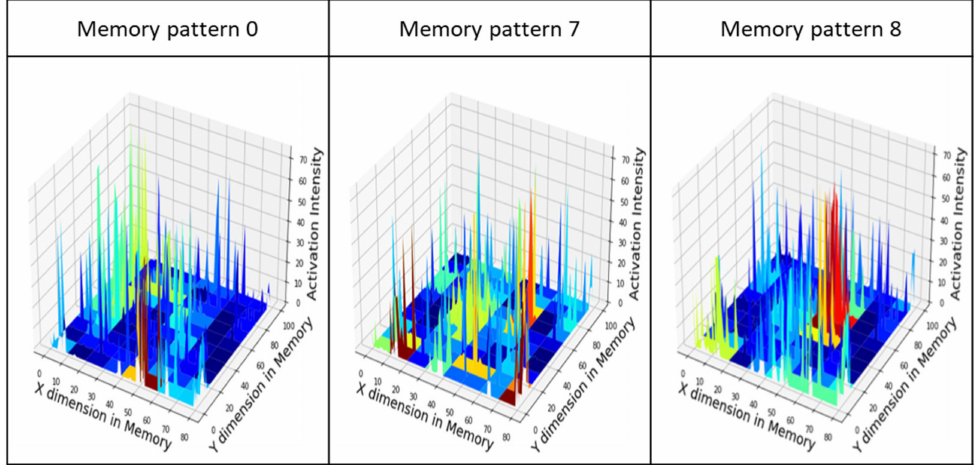
Figure 19. Examples of memory pattern formed through the pre-memory